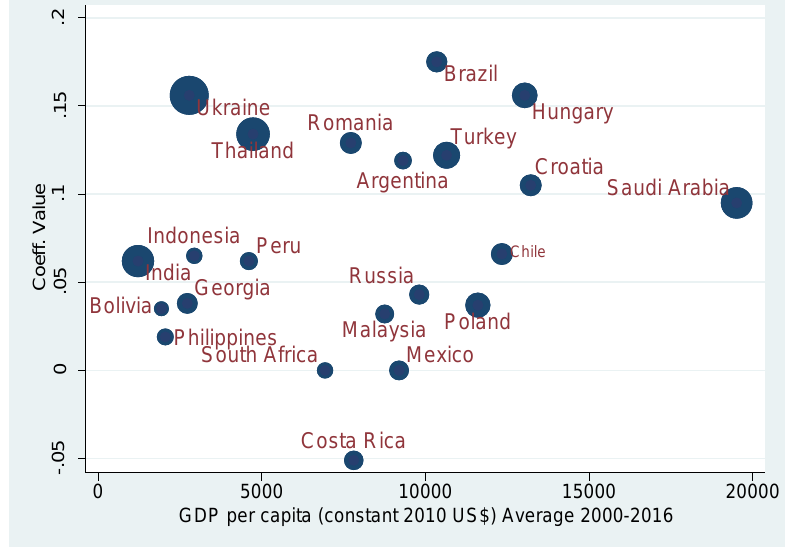
Note: Coefficient values extracted for individual countries in the sample from static specification in Table 6 (to save space, we do not present the graph drawn from coefficient values from dynamic specification in Tables 7a, 7b and 7c, which also shows a weak correlation between the two variables). GDP data is from World Bank. The size of circle presents standard